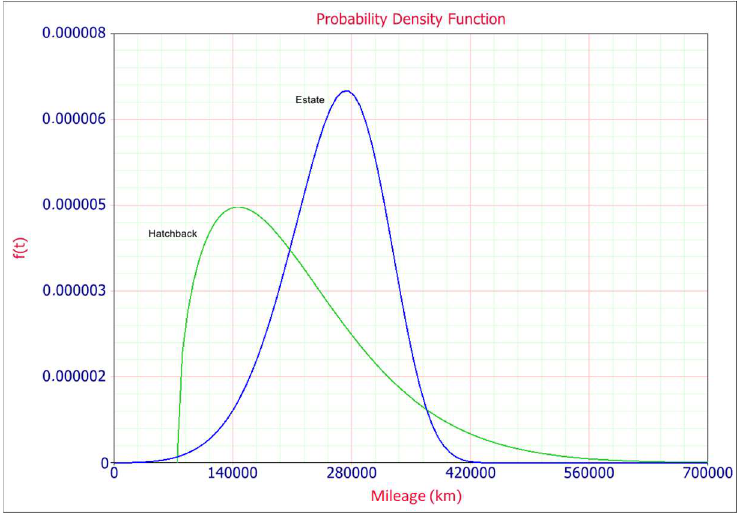
Figure 5. Probability density plot.